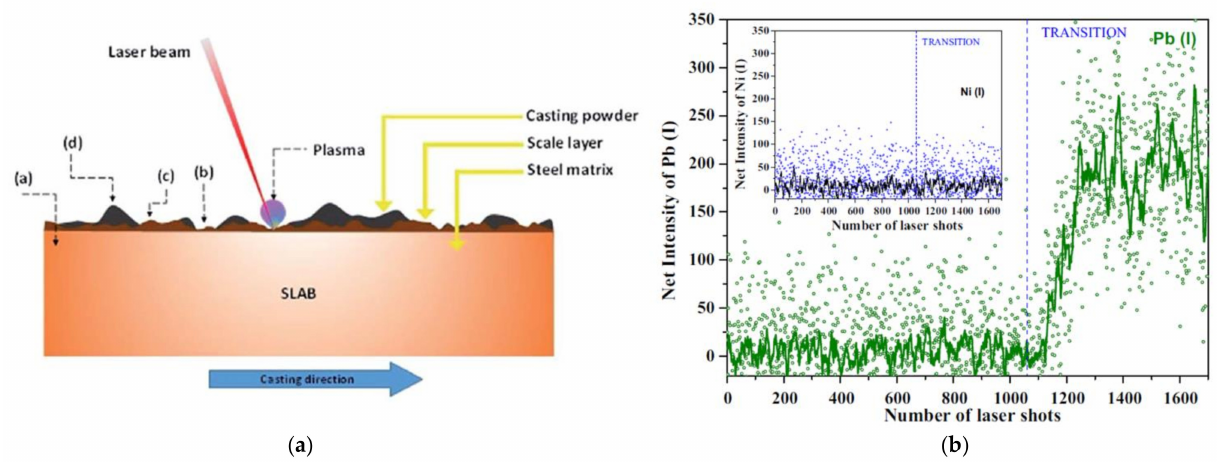
Figure 17. LIBS at-line measurement of hot steel slabs in the continuous steel casting process. ( a ) Schematic of a slab with steel matrix (a) and various surface layers (b–d). Adapted from [464]. ( b ) LIBS signal of Pb showing the transition between two different steel grades. The inset shows the signal for Ni. Solid lines are 25-point averages. Adapted from